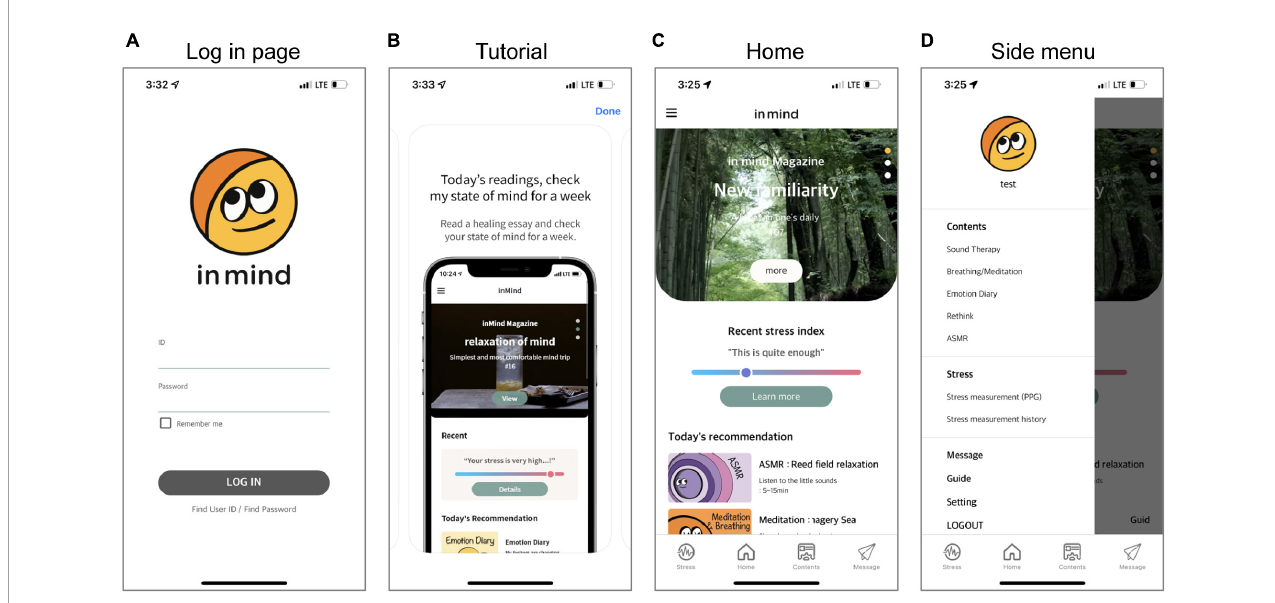
FIGURE3 Screenshots of the App user interface. All participants log in with their ID and password on the log-in page (A) . Participants can watch a tutorial about application use at any time (B) . The Home screen recommends treatment programs based on the results of participants’ recent objective stress monitoring, and participants can access the desired content from the menu bar (C) . Participants can also directly access content by category through the side menu (D)